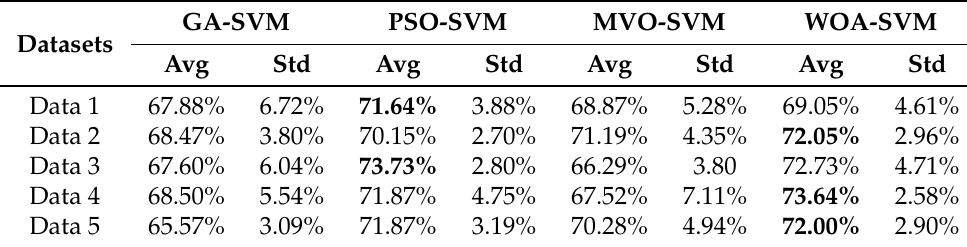
Table 8. Accuracy results of GA-SVM, PSO-SVM, MVO-SVM, and WOA-SVM for First-rules datasets.